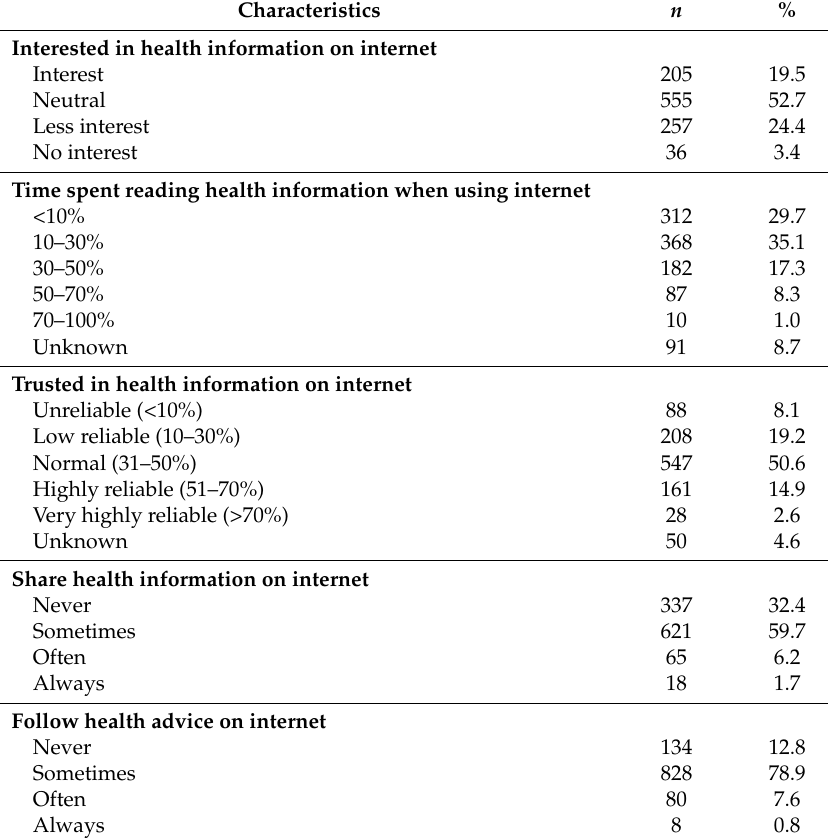
Table 2. Heath information seeking behavior among internet respondents ( n =